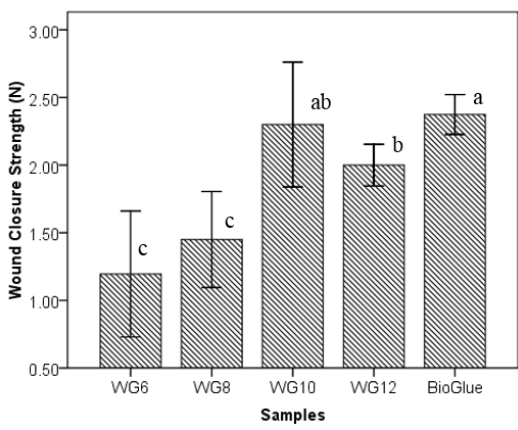
Figure 6. Effects of GTA on wound closure strength of WPI/GTA adhesive (The annotated letters indicate the statistical difference at significant level of 95.0%).